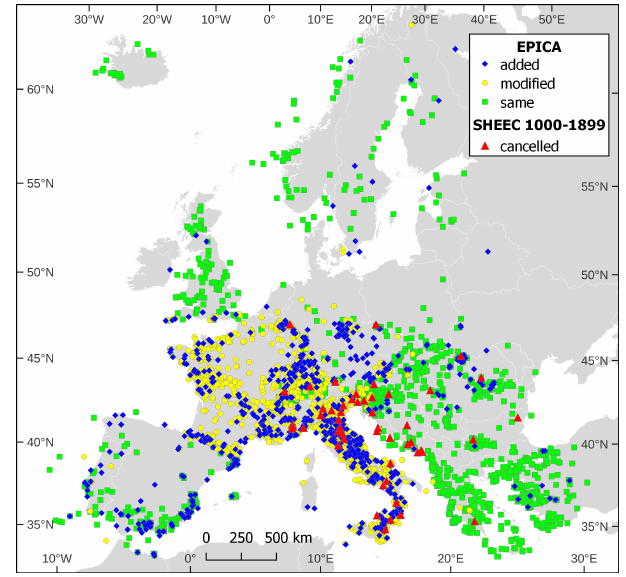
Figure 9. Locations of the earthquakes in EPICA, in comparison with SHEEC 1000–1899. Blue diamonds: earthquakes in EPICA that were not in SHEEC 1000–1899; yellow dots: earthquakes in both SHEEC 1000–1899 and EPICA, but with a different dataset; green squares: earthquakes in both SHEEC 1000–1899 and EPICA with the same dataset; red triangles: earthquakes in SHEEC 1000– 1899 that were